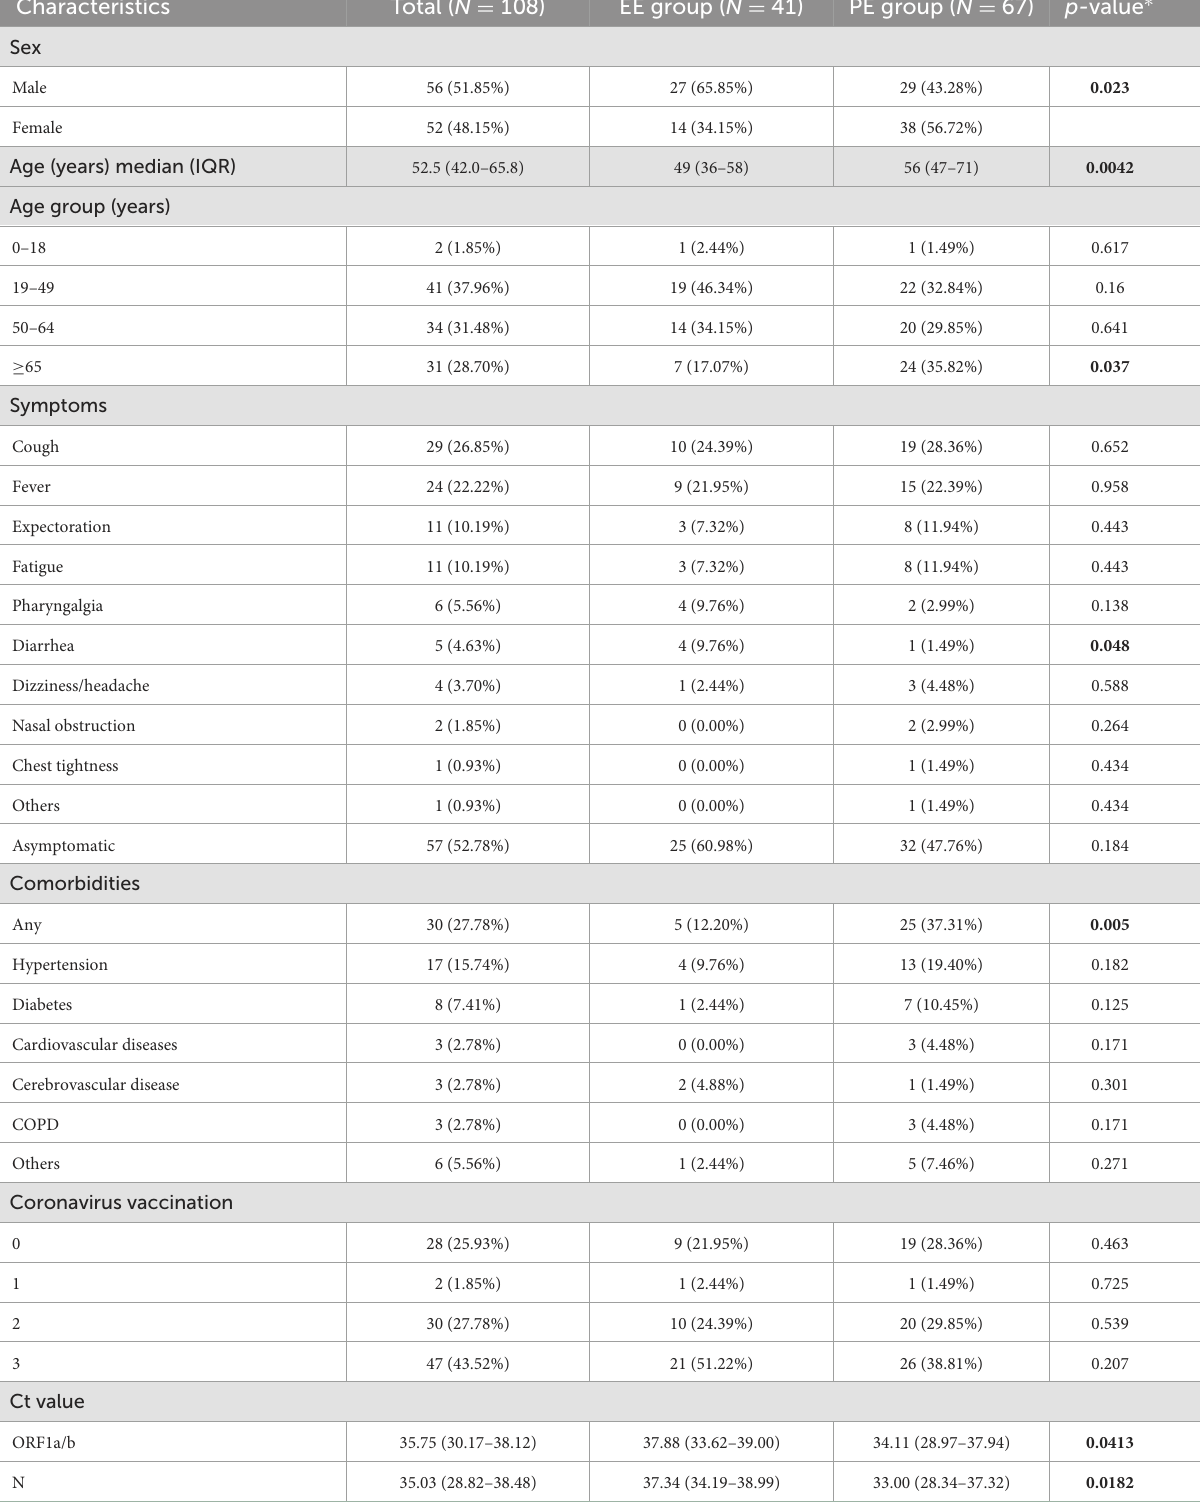
TABLE 1 Baseline characteristics of COVID-19